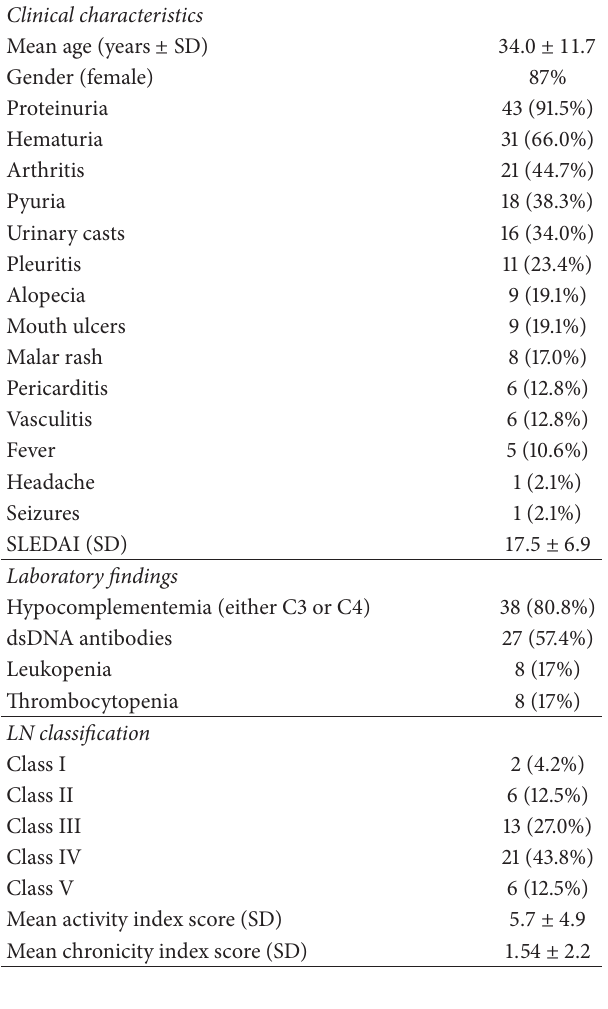
Table 1: General characteristics of 48 SLE patients with biopsy proven LN.